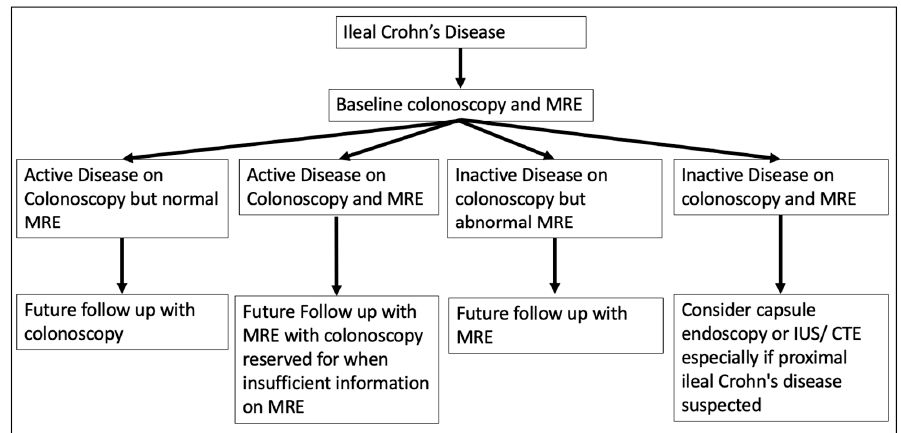
Figure 5. Potential CD activity assessment strategy.